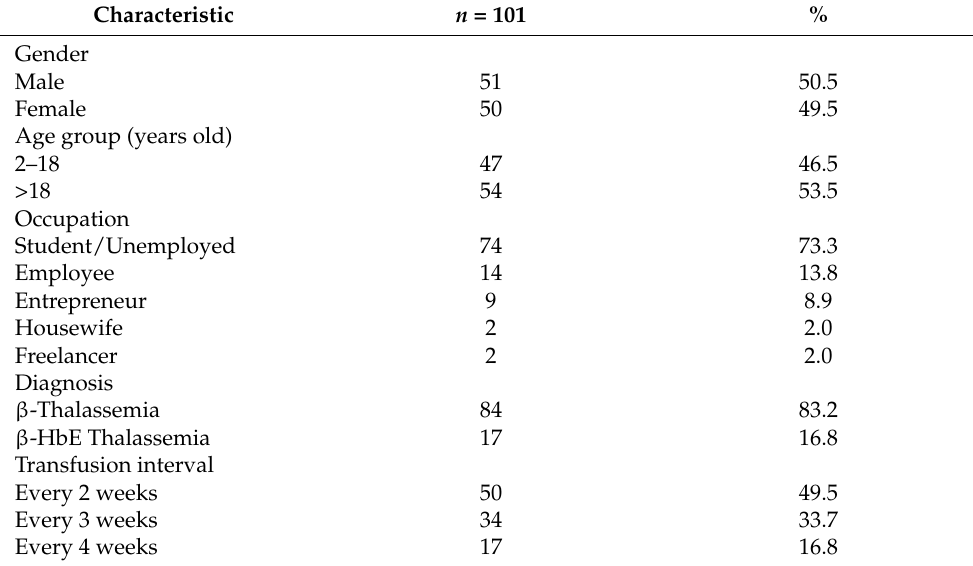
Table 1. Study population characteristics.